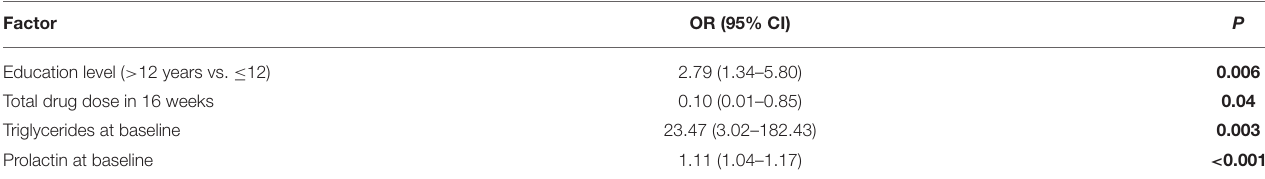
TABLE 3 | Factors associated with improvement of serum prolactin level to < 40 µ g/ml at week 16 among participants treated with vB6 as indicated by multivariate logistic regression modeling. Factor OR (95% CI) P Education level ( > 12 years vs. ≤ 12) 2.79 (1.34–5.80) 0.006 Total drug dose in 16